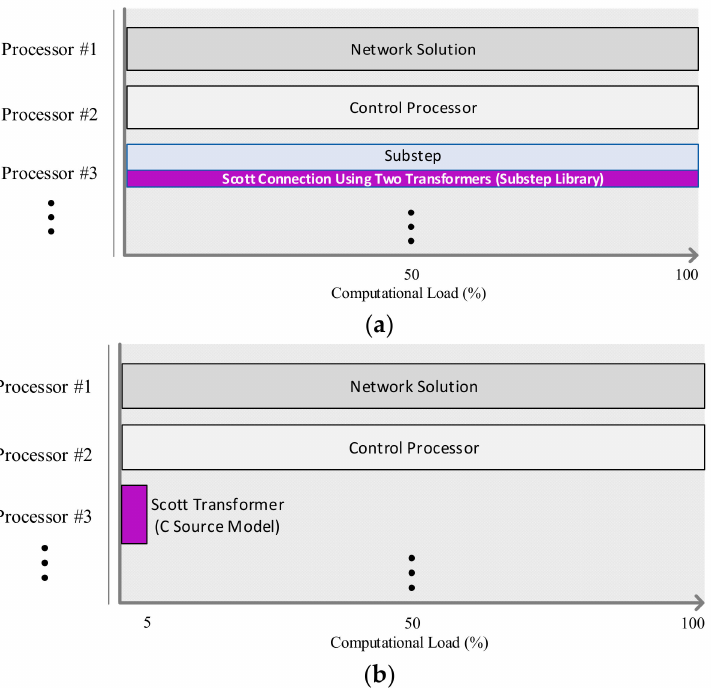
Figure 9. Comparison between computational loads of ( a ) Scott connection using the Substep library models (processor assignment for Scott connection using a single-phase transformer and 3-winding transformer from the Substep library) and ( b ) the proposed Scott transformer (processor assignment for Scott connection based on the proposed model).